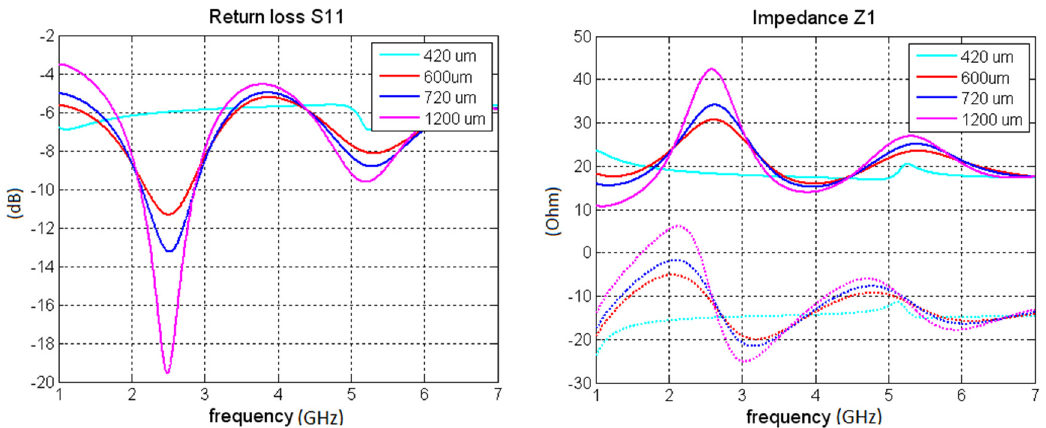
Figure 11. A simulation of characteristics of a unipole made from PU/MWCNT, input impedance as a function of conductivity.